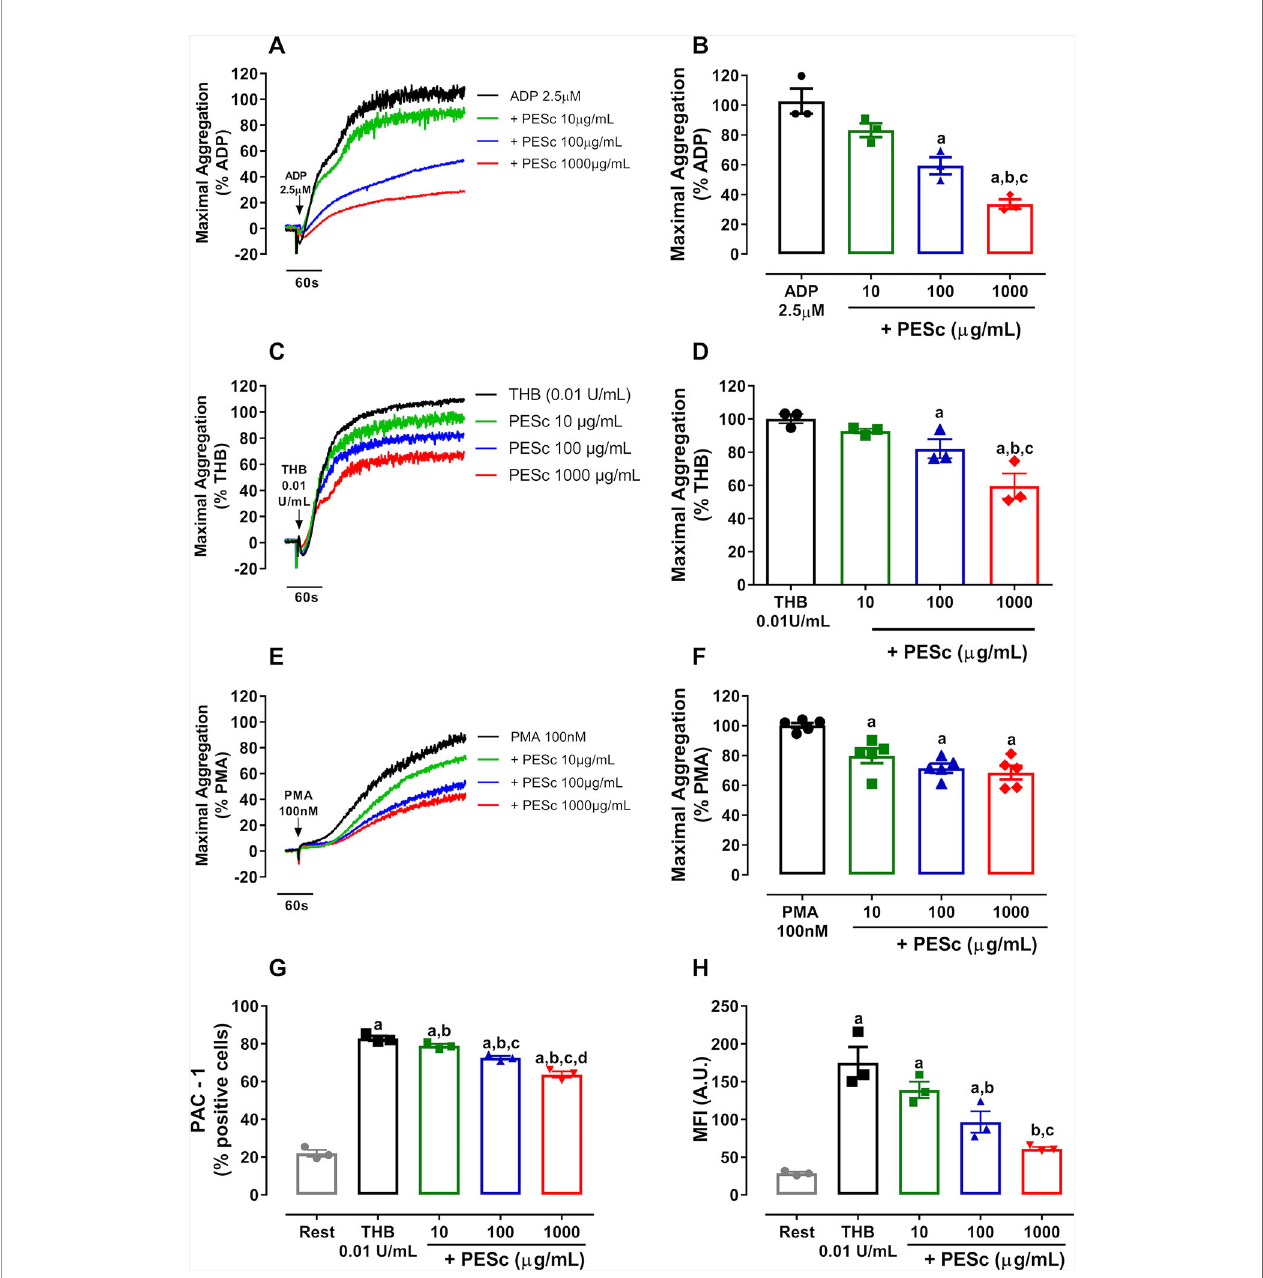
FIGURE 1 | PESc inhibits platelet aggregation and integrin a IIb b 3 activation. Platelet-rich plasma was pretreated with PESc (10, 100, or 1,000 m g/ml) for 25 min and stimulated with ADP (A) , thrombin (THB, C ), or PMA (E) . Quanti fi ed data is shown next to representative curves for ADP (B) , thrombin (D) , and PMA (F) stimulated platelet aggregation. Washed platelets were pre-treated with PESc under the same conditions, stimulated with thrombin, and incubated with PAC-1 antibody to measure integrin activation. (G) Percentage of PAC-1 positive events. (H) Mean fl uorescence intensity (MFI) of events. a p < 0.05 vs fi rst column of graph. b p < 0.05 vs second column of graph. c p < 0.05 vs third column of graph, d p < 0.05 vs fourth column of graph. Data analyzed by paired one-way ANOVA and Tukey as post-test. All bar graphs represent mean ± SEM and individual data points of at least three independent experiments. Arrows indicate when agonists were